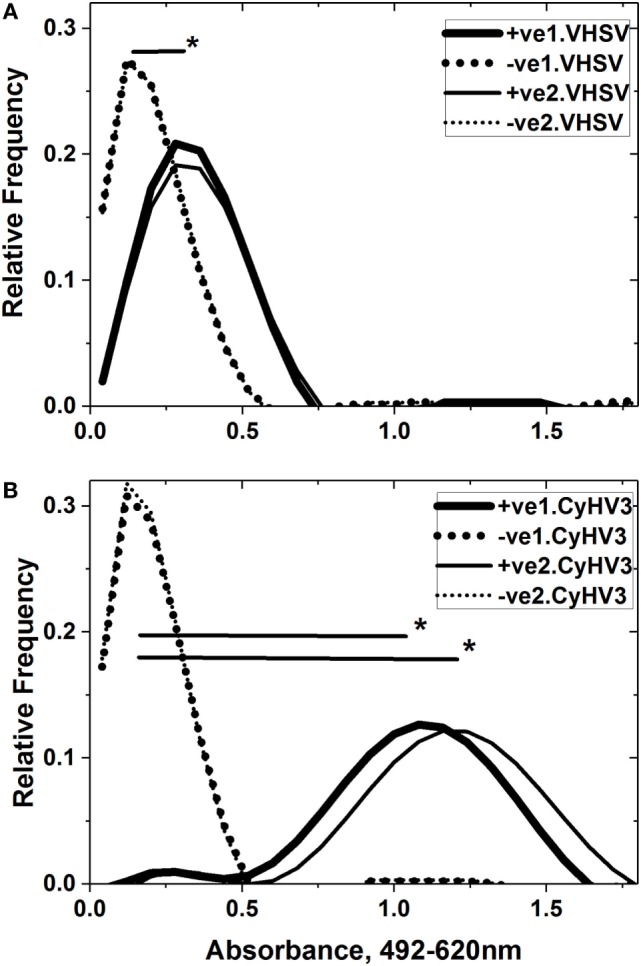
Comparison of consecutive IgM binding to purified viral hemorrhagic septicemia virus (VHSV) (A) and cyprinid herpes virus 3 (CyHV-3) (B). Sera from CyHV-3 infection-survivor and healthy carp populations were assayed by consecutive VHSV/CyHV-3 enzyme-linked immunosorbent assay (ELISA) in the same plate. Forward ELISA used VHSV first and CyHV-3 second (wide black lines and dots) while reverse ELISA used CyHV-3 first and VHSV second (thin black lines and dots). Absorbance profiles were obtained after normalization of raw absorbance values, distribution in 0.08 absorbance classes and polynomial fitting, as indicated in Section “Materials and Methods.” Black lines—IgM-binding profiles of sera from the CyHV-3 infection-survivor carp population (n = 48). Dot lines—IgM-binding profiles of sera from the healthy carp population (n = 48). +ve1.VHSV, CyHV-3 infection-survivor sera population in the first ELISA against VHSV. −ve1.VHSV, healthy sera population in the first ELISA against VHSV. +ve2.VHSV, CyHV-3 infection-survivor sera population in the second ELISA against VHSV. −ve2.VHSV, healthy sera population in the second ELISA against VHSV. +ve1.CyHV3, CyHV-3 infection-survivor sera population in the first ELISA against CyHV-3. −ve1.CyHV3, healthy sera population in the first ELISA against CyHV-3. +ve2.CyHV3, CyHV-3 infection-survivor sera population in the second ELISA against CyHV-3. −ve2.CyHV3, healthy sera population in the second ELISA against CyHV-3. *Significantly >0.2 threshold of the healthy sera population at the 0.05 level (Student’s t-test).